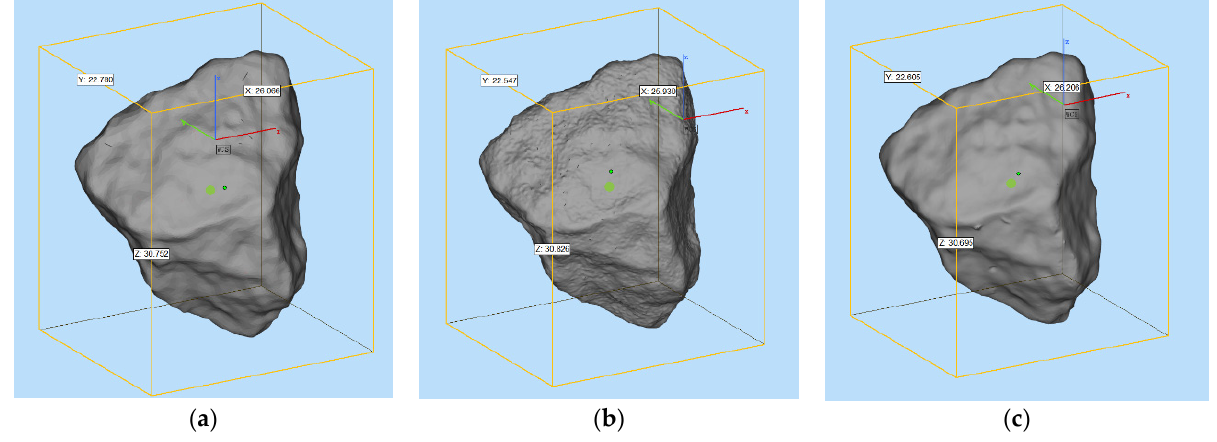
Figure 7. Three-dimensional appearance of printed aggregates ( a ): natural aggregate; ( b ): photosensitive resin-based aggregate (SLA printing); ( c ): ABS resign-based aggregate (DLP printing). Table 4. The deviations between resin-based aggregates and natural aggregates.